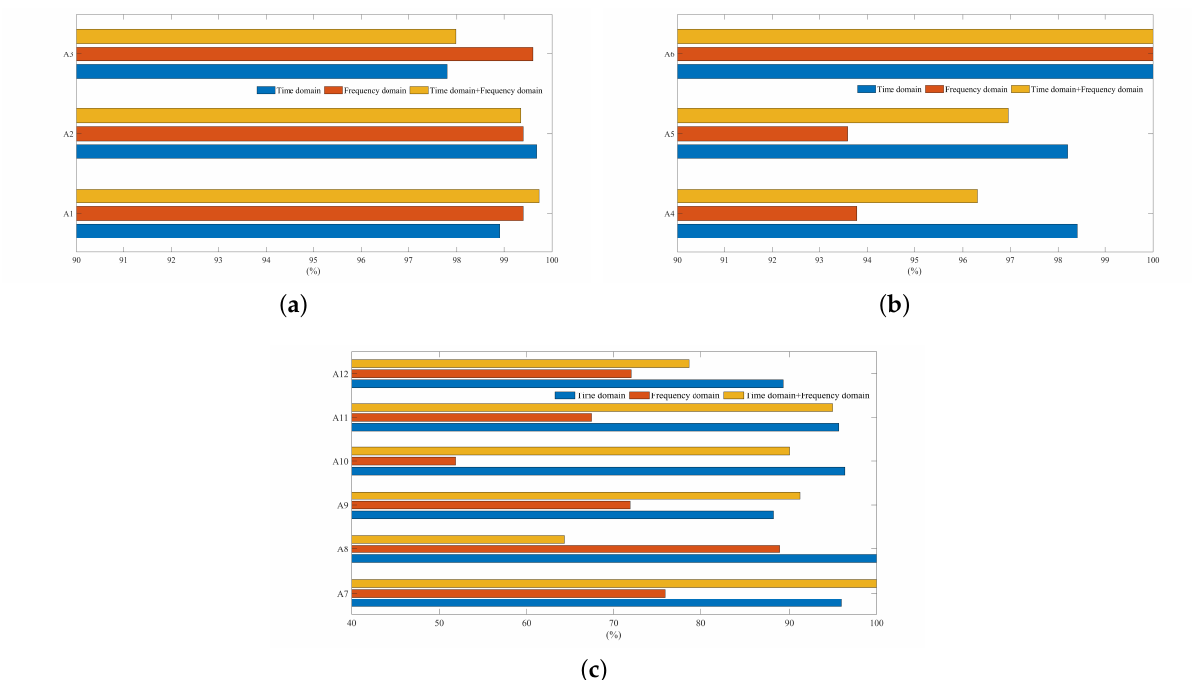
Figure 8. ( a ) Comparison of recall rates of dynamic actions under different characteristics. ( b ) Comparison of recall rates of static actions under different characteristics. ( c ) Comparison of recall rates of transition actions under different